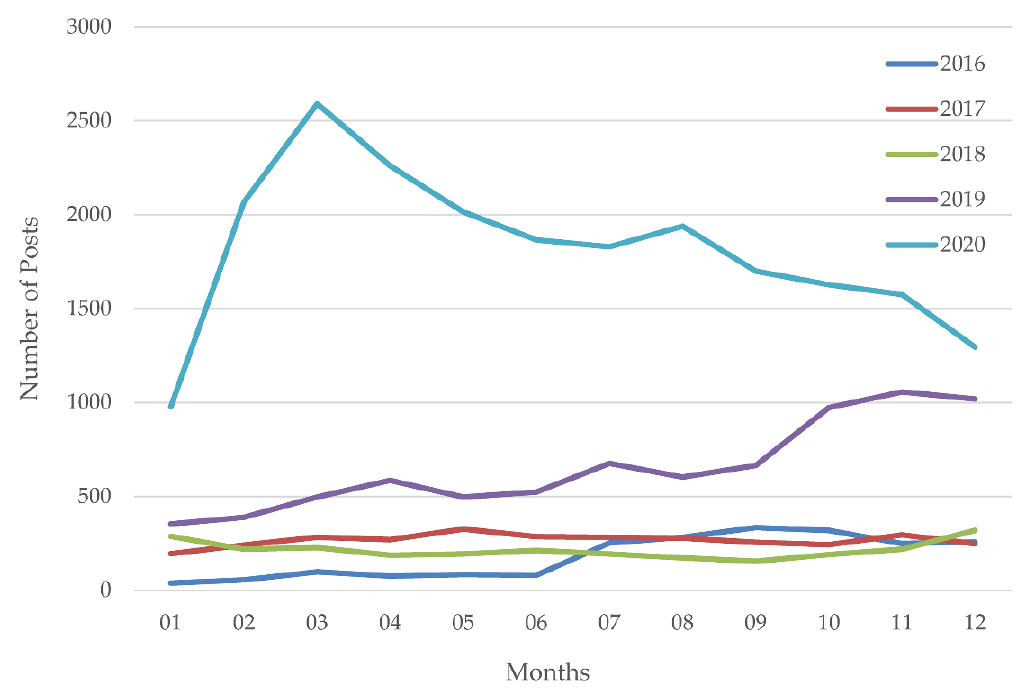
Figure 2. The yearly trends for the PHS posts before and during the COVID-19 pandemic.